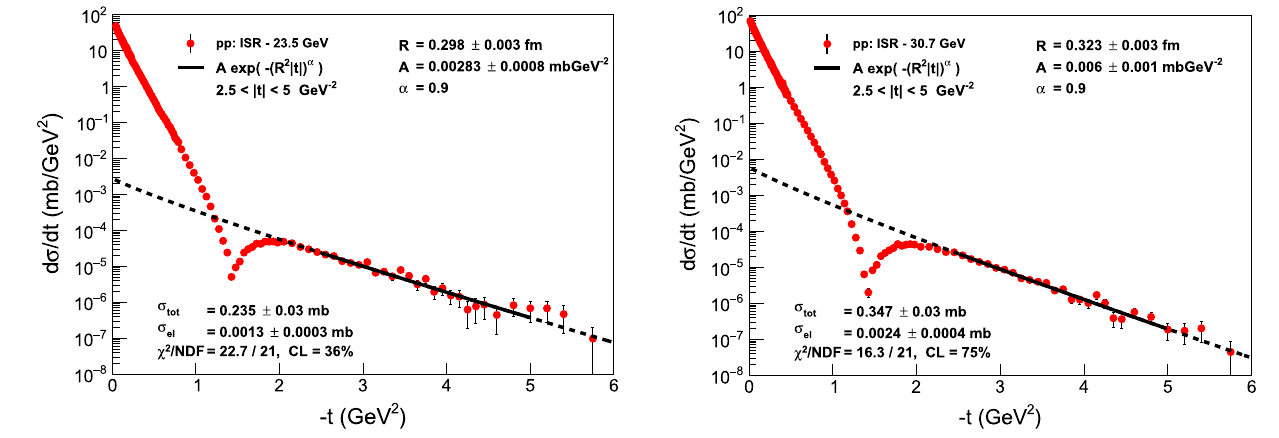
√ s = 30 . 7 GeV [45], with